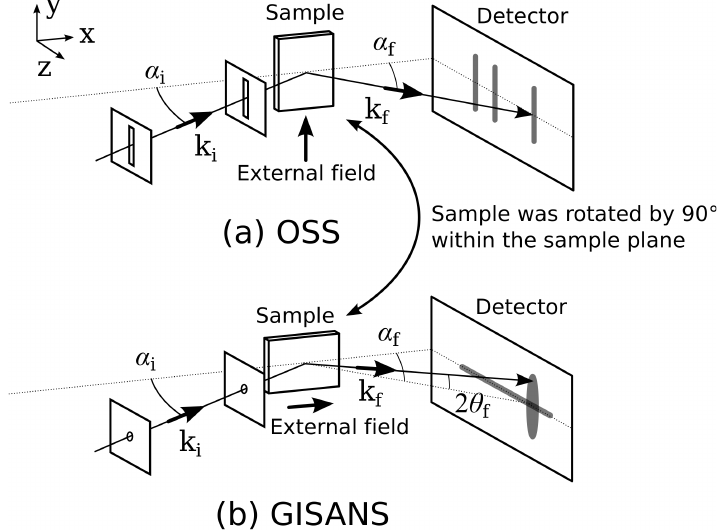
Figure 1. Scattering geometry of the off-specular neutron scattering (OSS) ( a ) and grazing-incidence small-angle neutron scattering (GISANS) ( b ) measurements. The external field was applied to the y - and x -axes in the OSS and GISANS, respectively. The sample was rotated by 90 ◦ within the sample plane between the OSS and GISANS to ensure that the same structure was